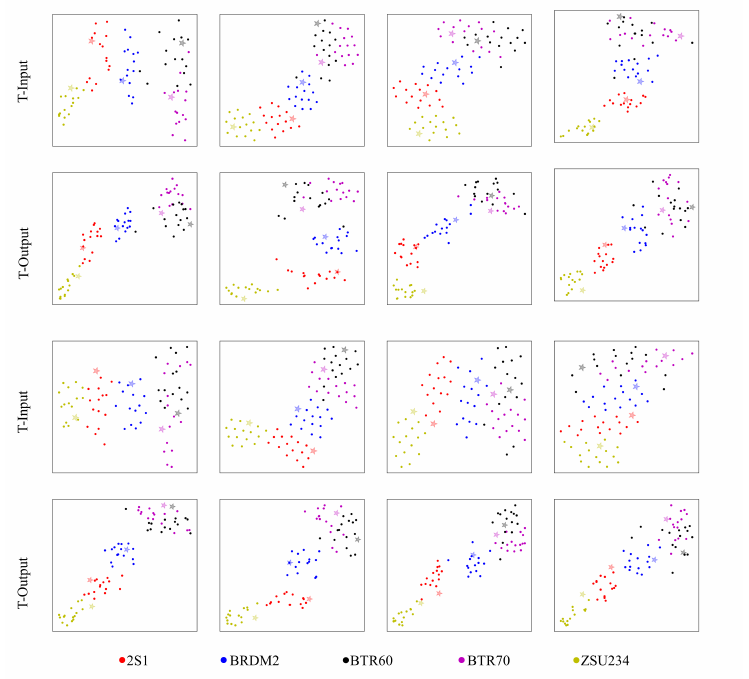
Figure 8. Visualization of the input (the first and third rows) and output features (the second and last rows) of IAT under the 1 shot condition using t-SNE. Asterisks and dots represent the features of support images and query images, respectively. Different colors correspond to different